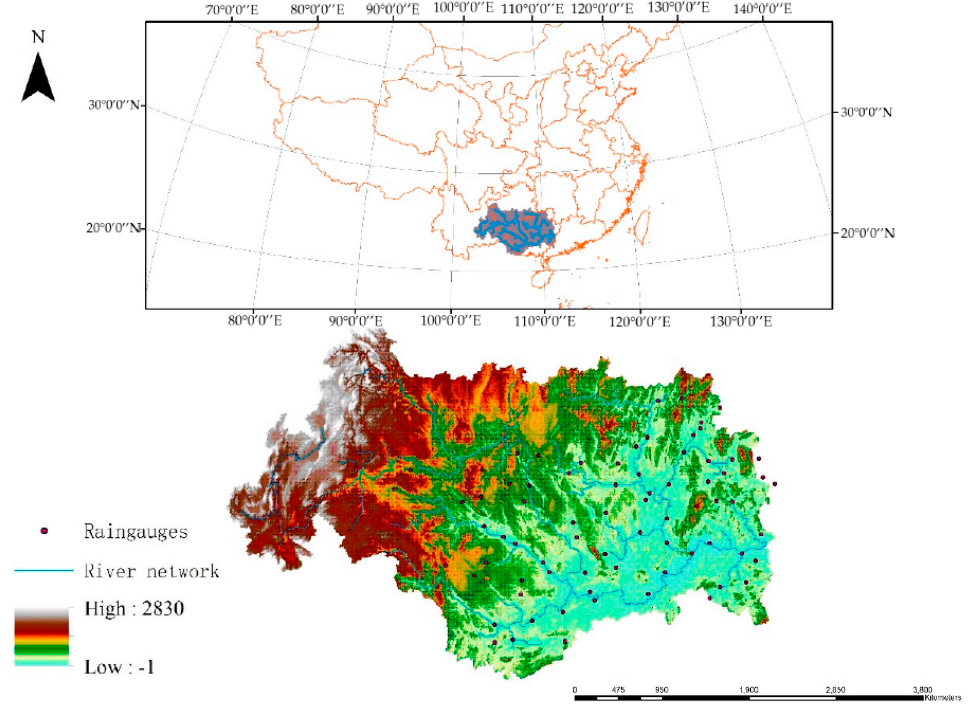
Figure 1. Xijiang Basin (upstream of Wuzhou flow station).